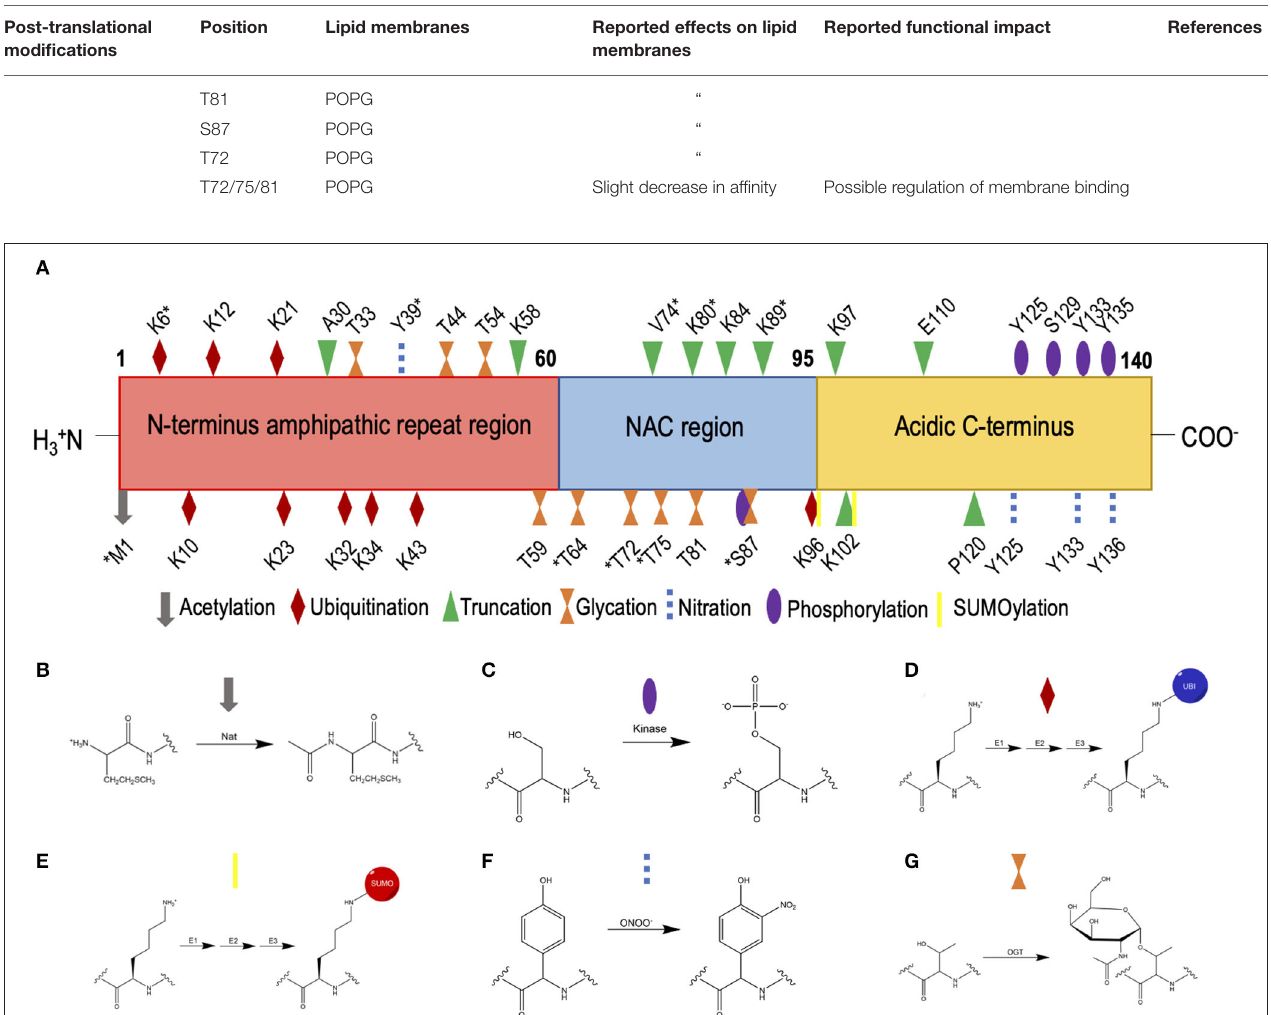
binding to lipid membranes (SDS micelles and POPG vesicles)